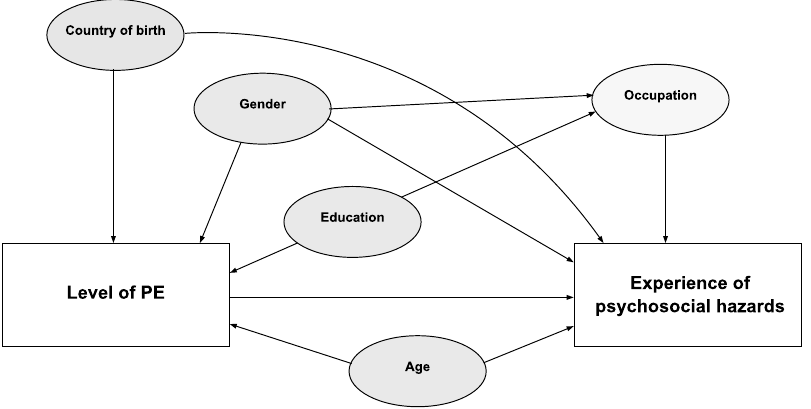
Figure 1. DAG (directed acyclic graph) for the effect of level of precarious employment (PE) on psychosocial hazards.